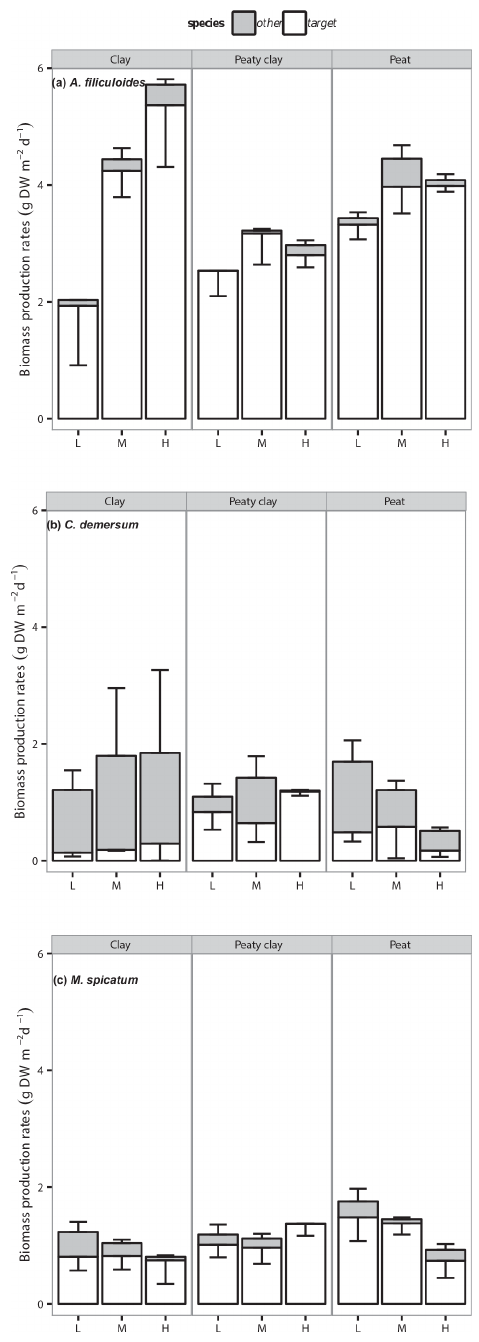
Figure 3. Biomass production rates (in gDWm − 2 d − 1 ) of A. fil- iculoides (a) , C. demersum (b) , M. spicatum (c) and other, non- target plants (e.g., floating algae, Zanichellia spp. and other plants) grown on different sediment types and subjected to different nu- trient loadings (L: 0.43mgPm − 2 d − 1 ; M: 21.4mgPm − 2 d − 1 ; H: 85.7mgPm − 2 d − 1 ) . Average biomass production rates of target species ( − SEM) and other plants ( + SEM) are